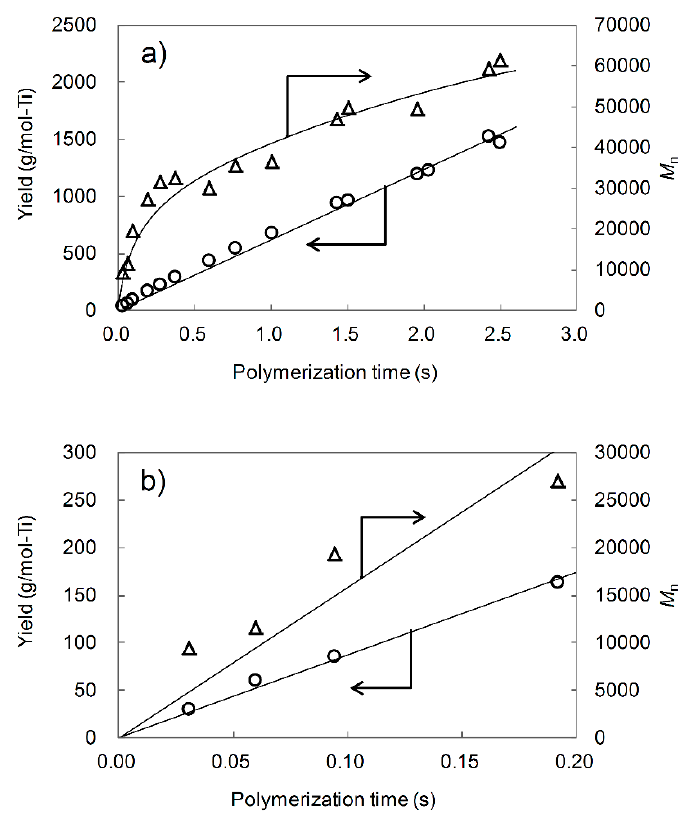
Figure 5. ( a ) Yield and M n development in propylene polymerization by the LSF method using a TiCl 4 /1,3-diether/MgCl 2 -based catalyst; ( b ) An expanded view up to the polymerization time of 0.2 s [21].